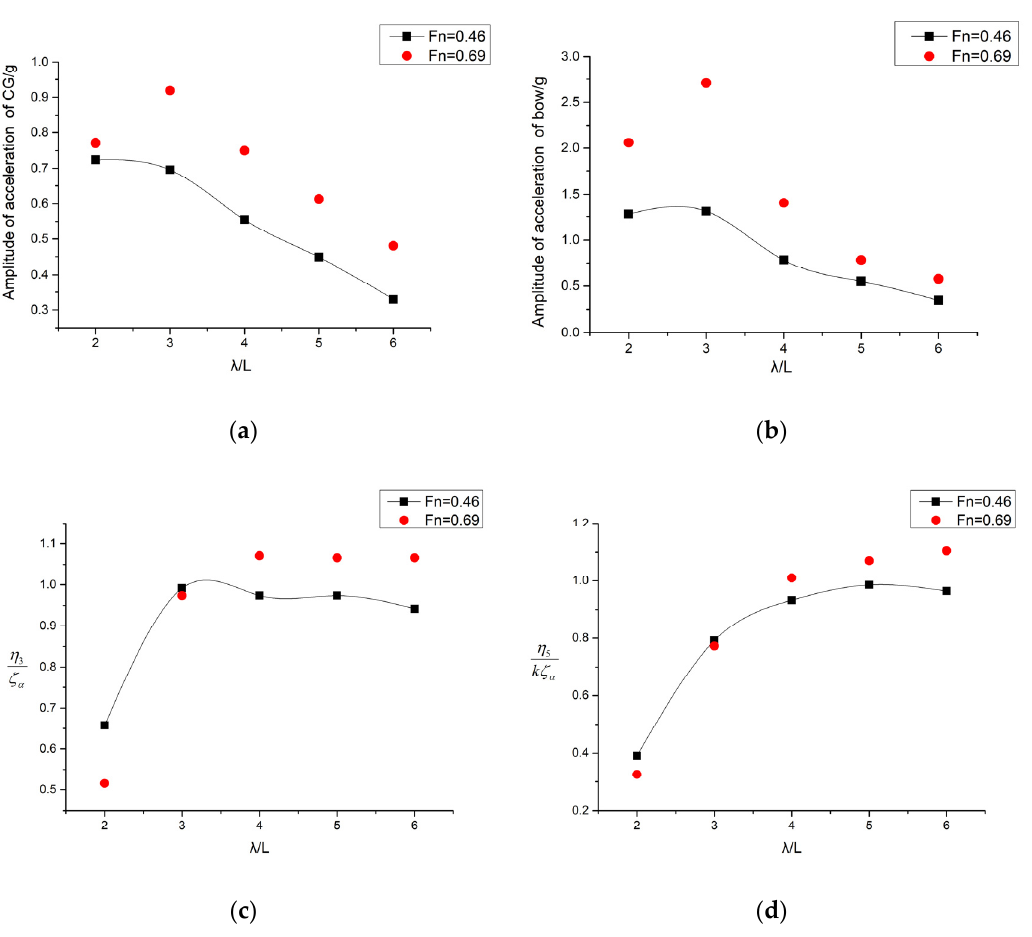
Figure 19. Comparison of the RAOs at two speeds: ( a ) Amplitudes of the acceleration of the CG; ( b ) Amplitudes of the acceleration of the bow; ( c ) Amplitudes of the heave; ( d ) Amplitudes of the pitch.